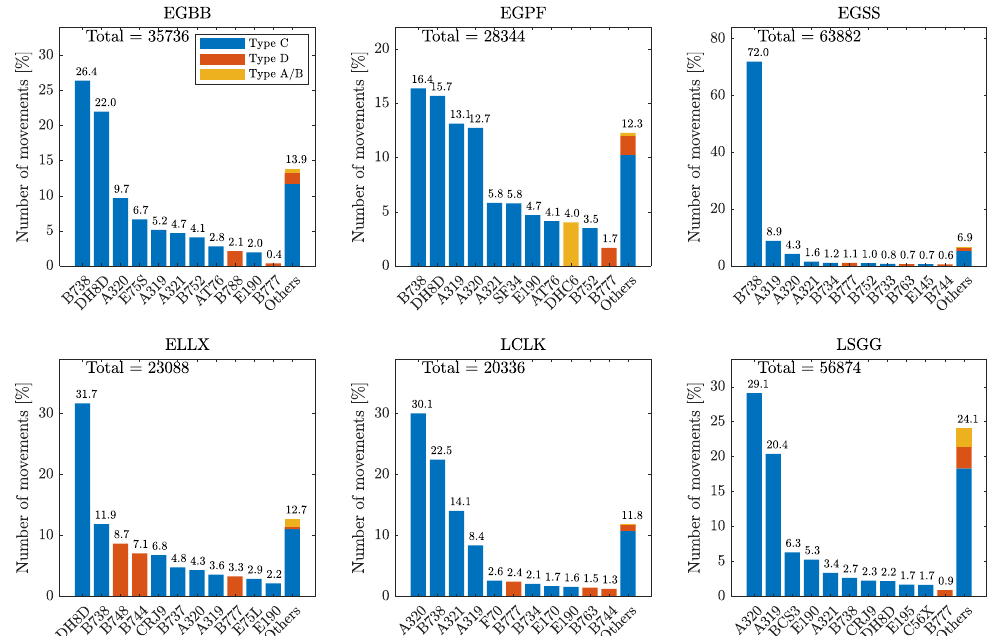
Figure 5. Aircraft type variability at six selected airports in Europe and the UK: percentage of movements per aircraft type with respect to the total number of flight operations (approach and departure) along the months of March, June, September and December of the year of 2018. The aircraft are categorized according to the wake turbulence classification of the FAA